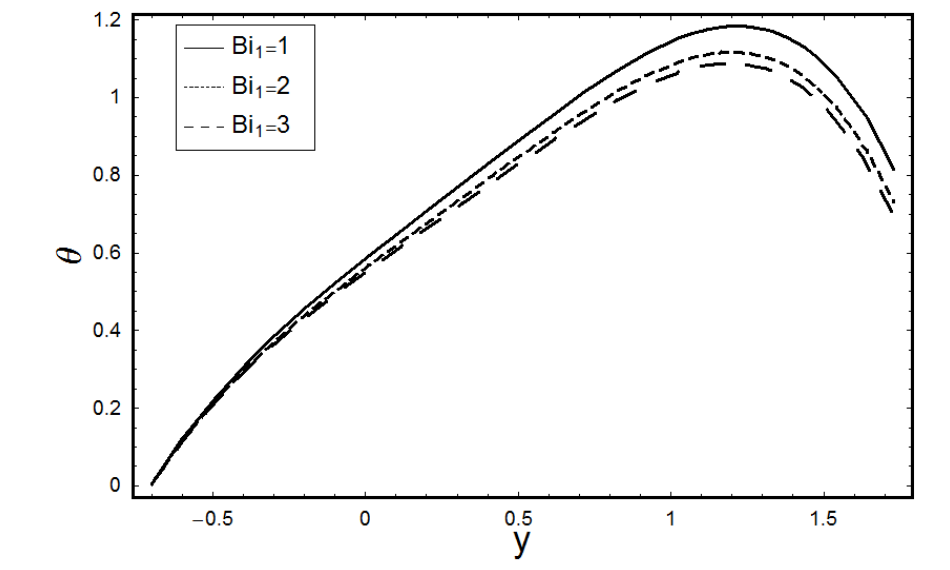
Figure 12. Variation in θ for Bi 1 with a = 0.3, b = 0.3, d = 0.6, φ = π /4, Θ = 1, x = 0, n = 1.5, Br = 0.5, b ∗ = 0.2 and Bi 2 = 10.